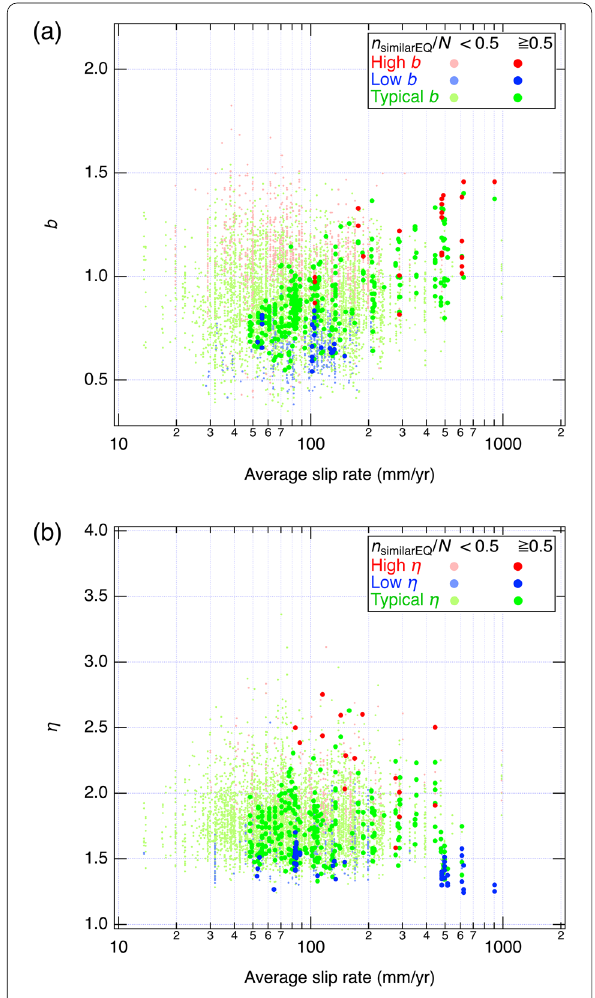
Fig. 10 Relationship between a b and b η and the average slip velocity estimated on the same spatial grid. All results for each N and l are shown together. Red, blue, and green symbols indicate high, low, and typical b - or η -values, respectively, and the ratio of similar earthquakes to the number of analyzed hypocenters ( N ) highlighted